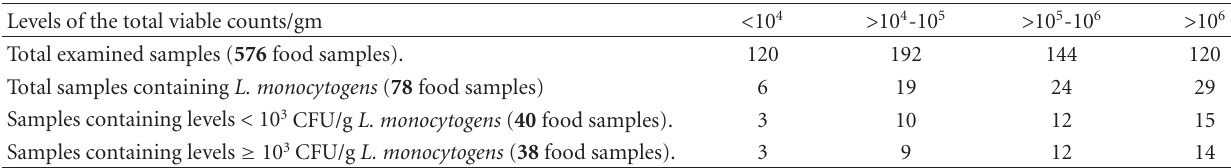
Table 2: TVCs in relation to levels of contamination by L. monocytogens